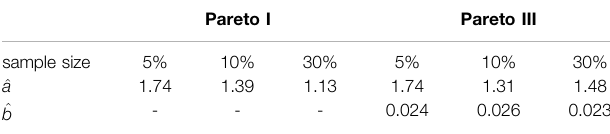
TABLE 1 | Estimated coef fi cients for Pareto Type I and III on Fortune 500 data using different upper tail fractions of observations. Pareto I Pareto